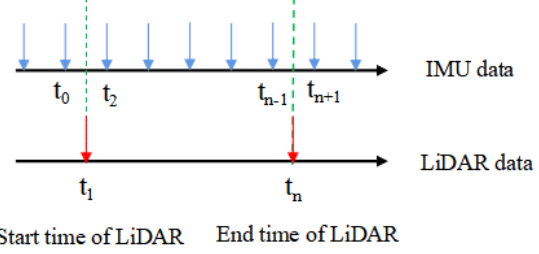
Figure 2. Schematic diagram of linear interpolation of IMU data.